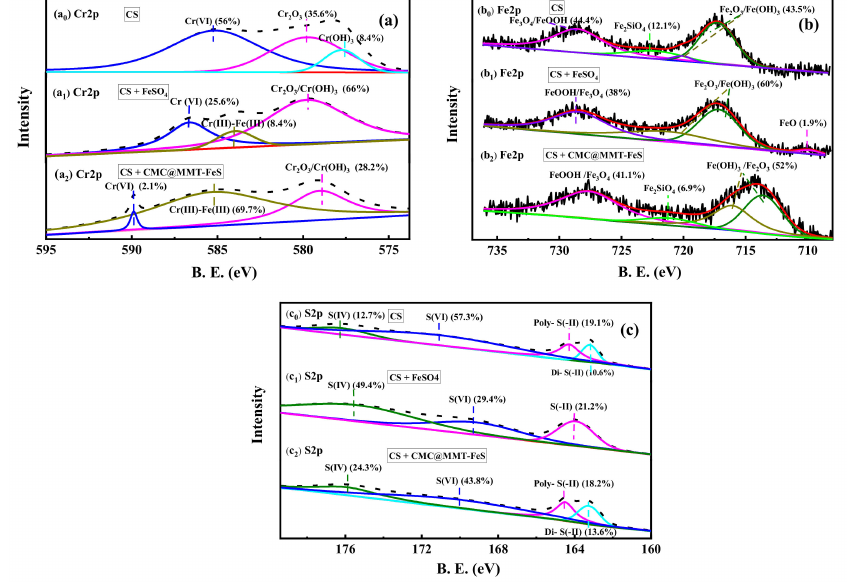
Figure 6. Chemical composition of ( a ) chromium (Cr), ( b ) iron (Fe), and ( c ) sulfur (S) in the surface of soil samples before and after treatment with 0.5 CMC@MMT-FeS and FeSO 4